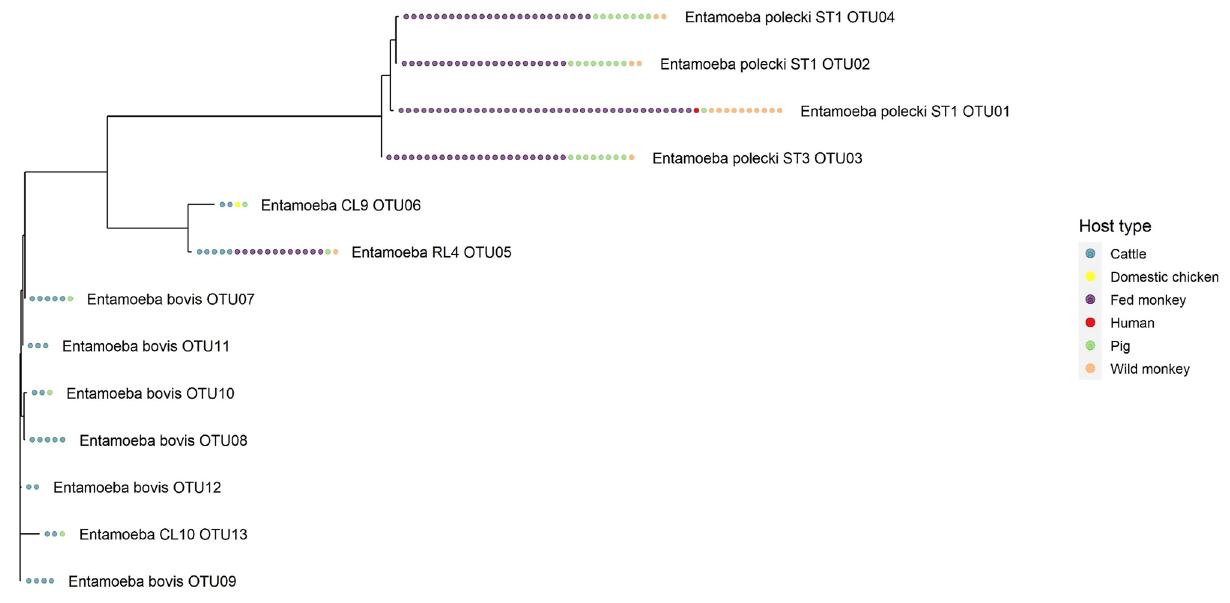
Figure 3. Host spectrum and number of positive faecal samples for all the 13 Entamoeba OTUs amplified in 65 of 115 faecal